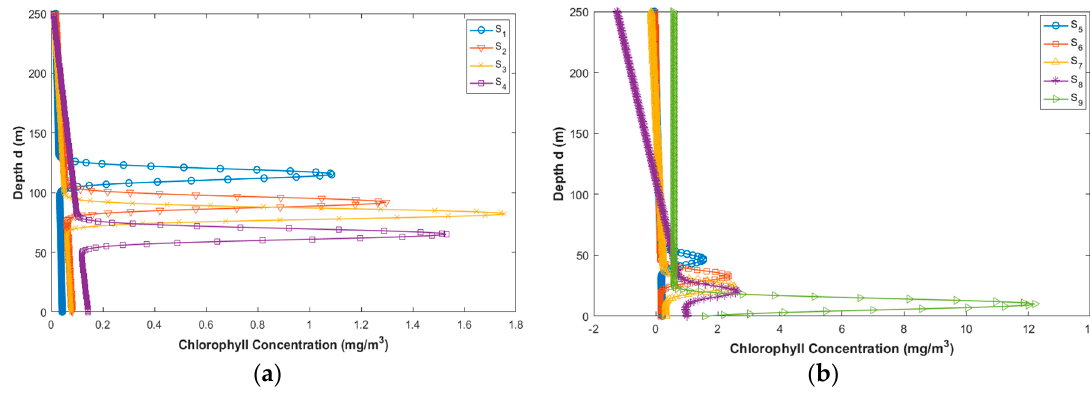
Figure 2. ( a ) Chlorophyll concentration depth profile different ranges of surface chlorophyll level S 1 –